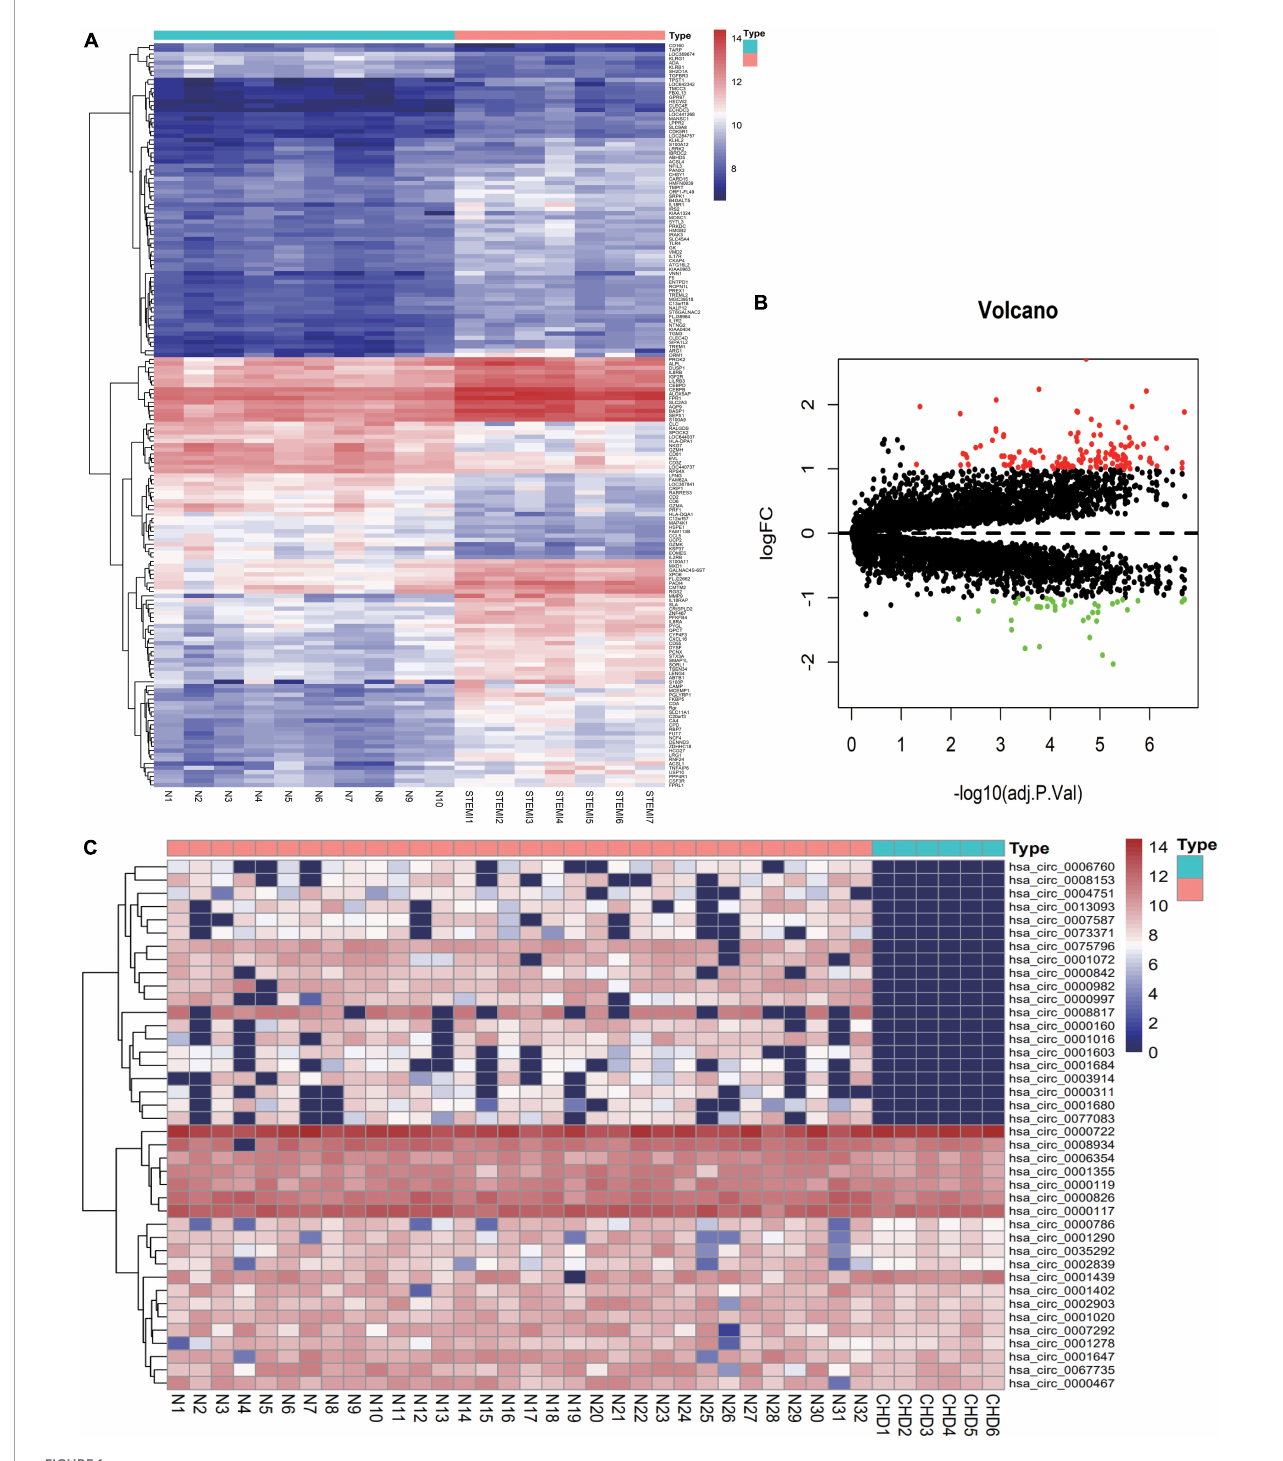
FIGURE1 Distribution of differentially expressed genes. (A) Heat maps of differentially expressed genes in plasma derived from patients with acute myocardial infarction were divided into acute myocardial infarction (ACS) group (7 cases) and healthy control group (10 cases). Blue to red successively represent gene expression levels from low to high. (B) Volcano map of ACS differentially expressed genes. (C) Heat maps of differentially expressed circRNA genes in patients with CHD derived from exosomes were divided into CHD group (6 cases) and healthy control group (32 cases). Blue to red represent gene expression from low to